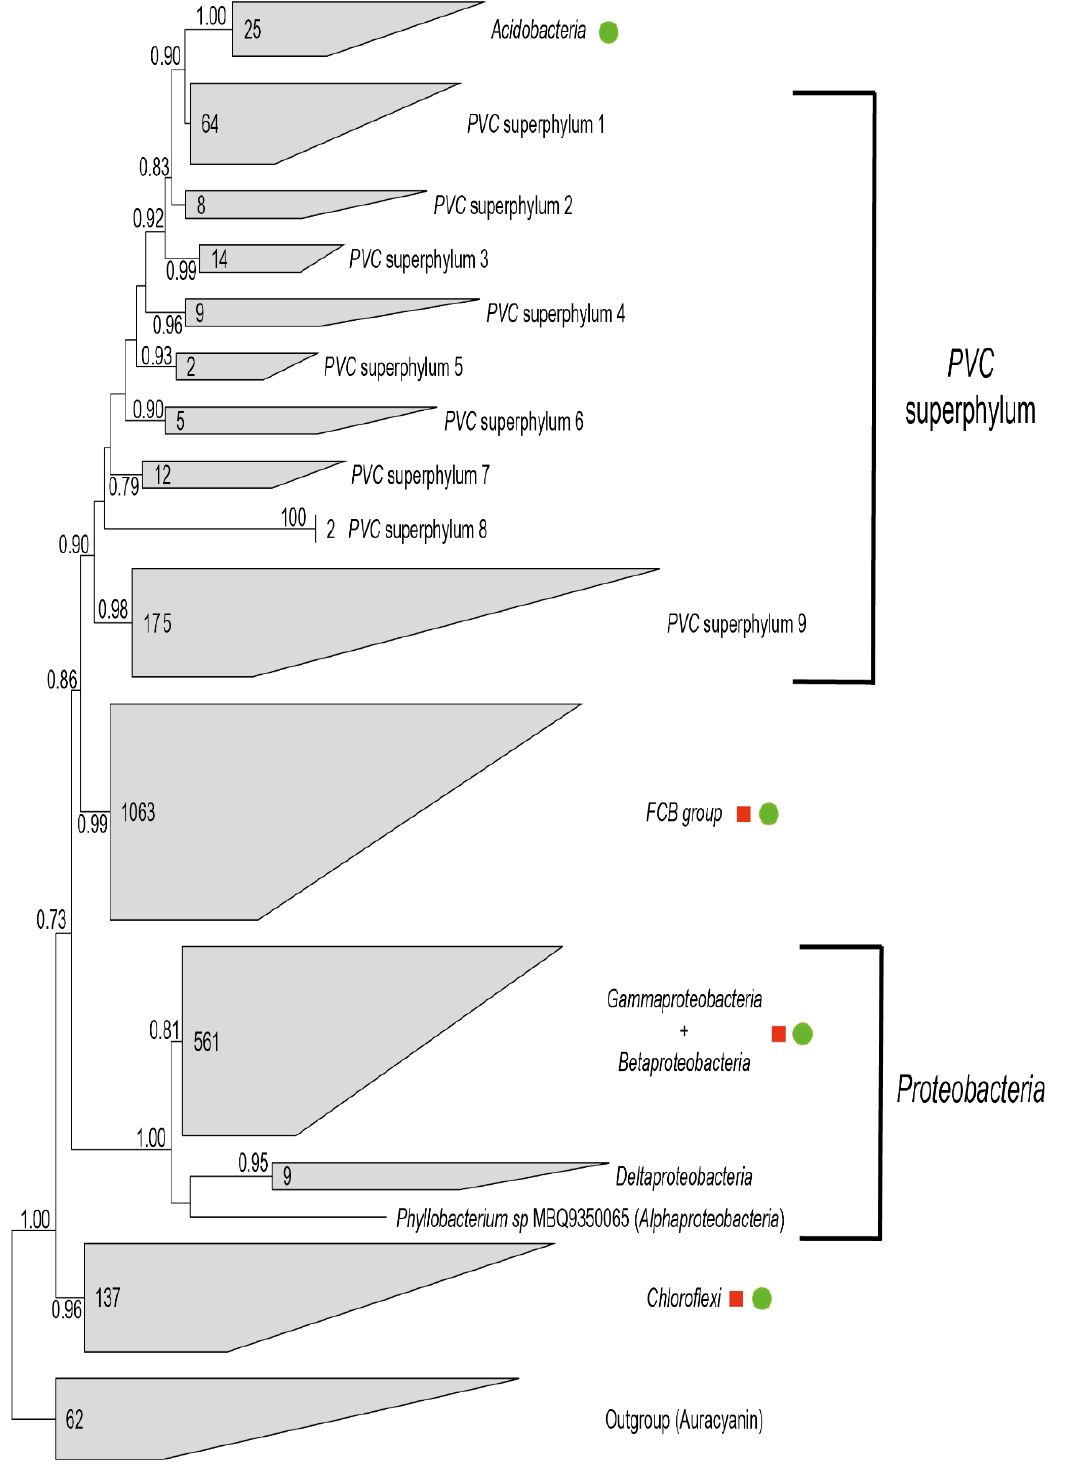
Figure 3. Phylogenetic analysis of retrieved azurin sequences. Maximum-Likelihood tree based on the amino-acidic sequences of the retrieved azurin sequences. Numbers on the nodes indicate the Shimodaira–Hasegawa (SH) test values for the relative nodes. Only values higher than 0.70 for the SH test were shown. Numbers inside the cluster indicate the number of sequences for each cluster. Red squares indicate the presence of Alphaproteobacteria -related sequences in the cluster, while green circles indicate presence of Actinobacteria -related sequences inside the cluster.